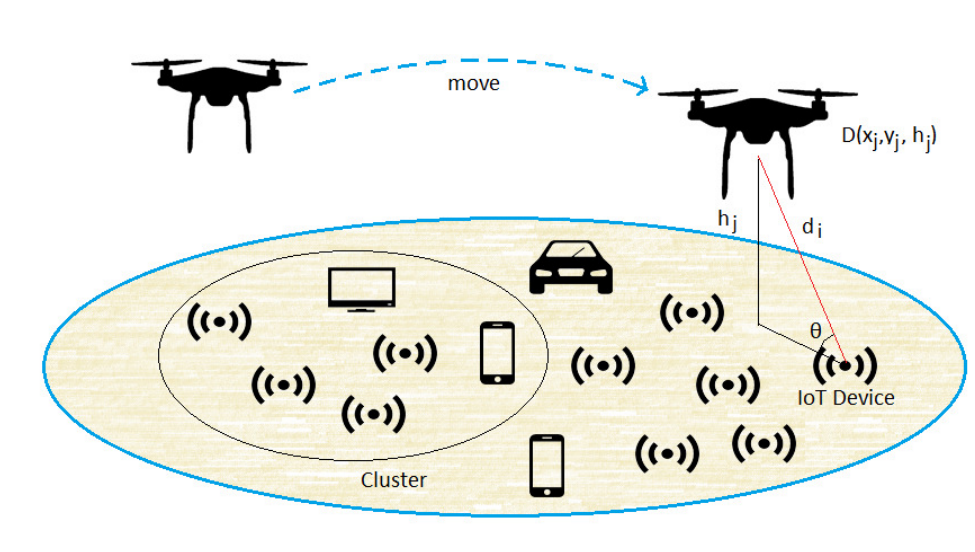
Figure 1. System model.